Question: In a single sentence, describe what this figure presents.
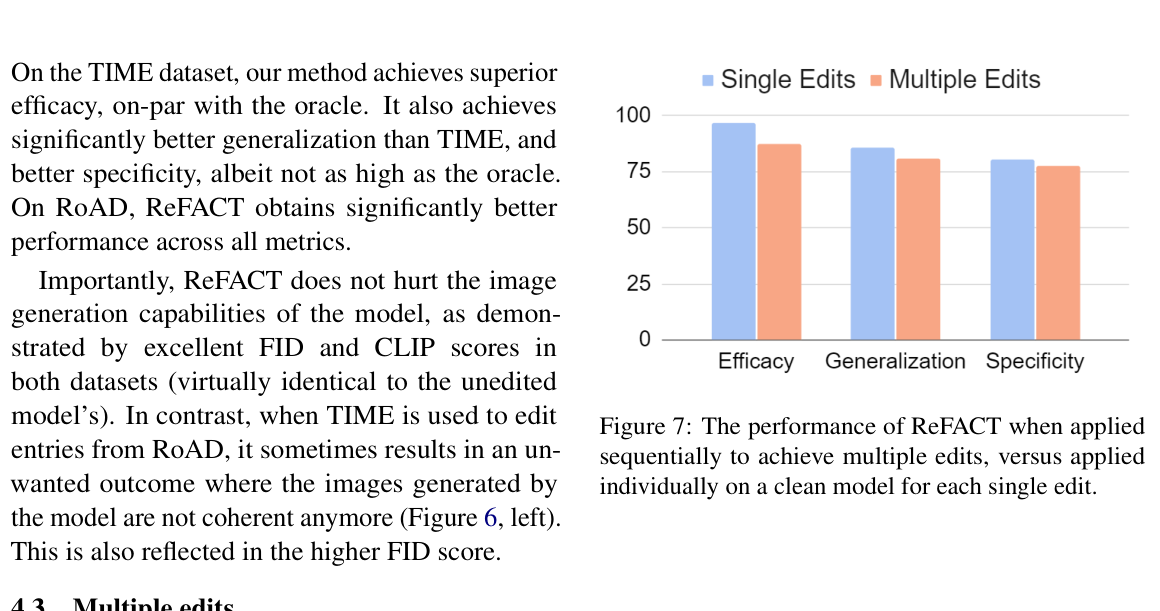
Answer: The performance of ReFACT when applied sequentially to achieve multiple edits, versus applied individually on a clean model for each single edit.